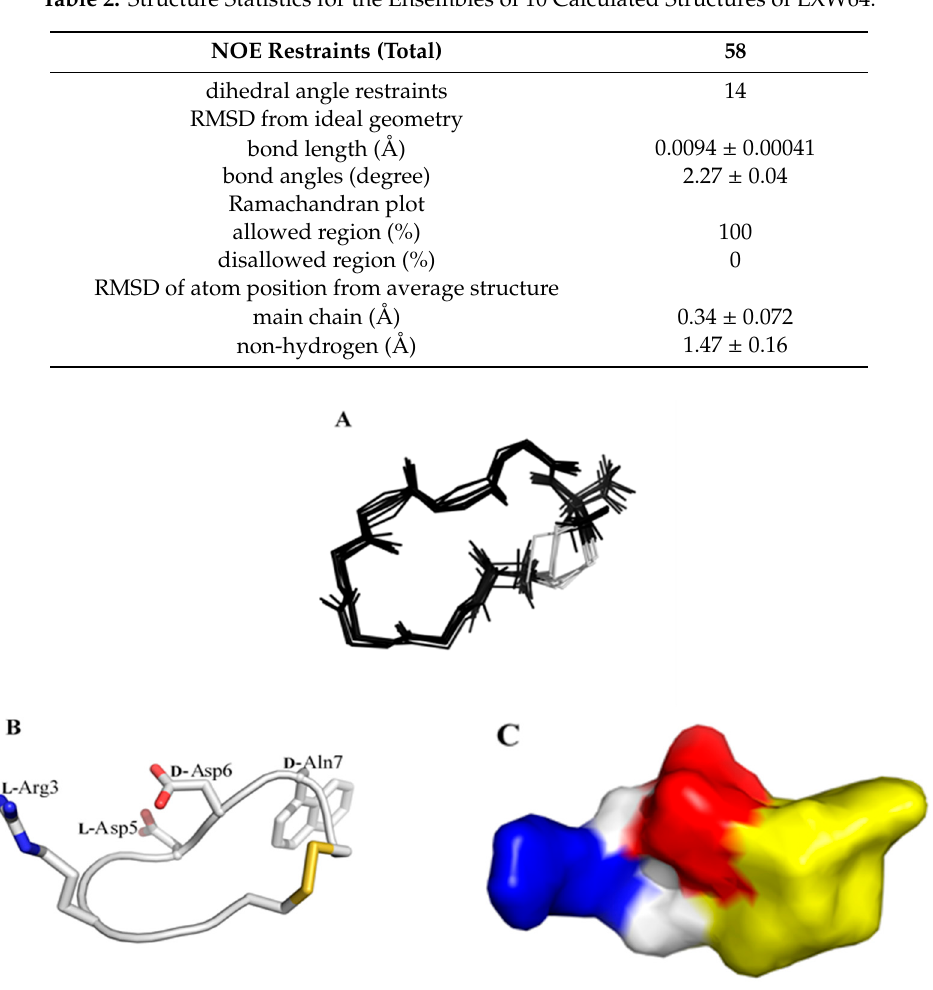
Figure 2. NMR-derived structures of LXW64. ( A ) An ensemble of 10 superimposed minimum energy structures. ( B ) Sticks representation of the energy-minimized average structure, in which L- Arg3, L -Asp5, D-Asp6 and D-Nal1 (X7) are labeled. ( C ) Representation of the molecular surface of LXW64, colored by electrostatic potential. Blue and red color represents positive (Arg) and negative (Asp) potential, respectively. The hydrophobic portion is highlighted in yellow.